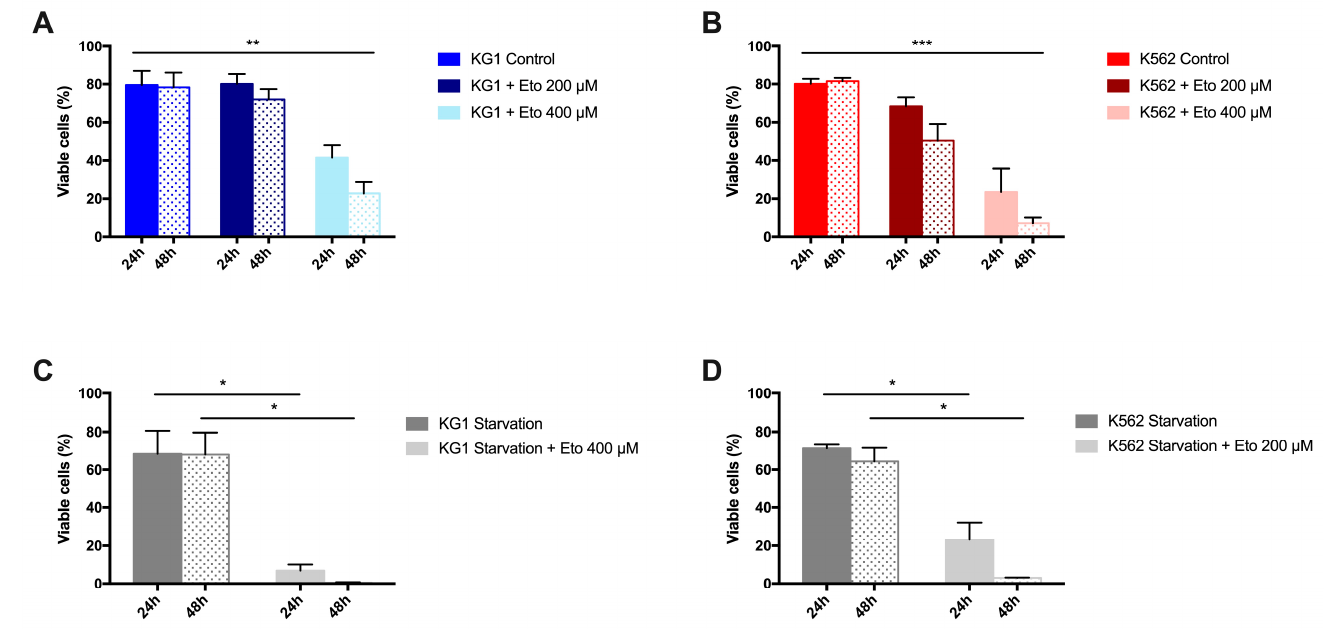
Figure 3. Impact of etomoxir and/or starvation on cell proliferation in KG1 and K562. ( A , B ) Percentage of viable cells in basal state, and with two concentrations of etomoxir (200 and 400 µ M) in KG1 and K562 cells, respectively. ( C , D ) Percentage of viable cells in starvation and in starvation with etomoxir in KG1 and K562 cells, respectively. * p < 0.05, ** p < 0.01, *** p < 0.001.